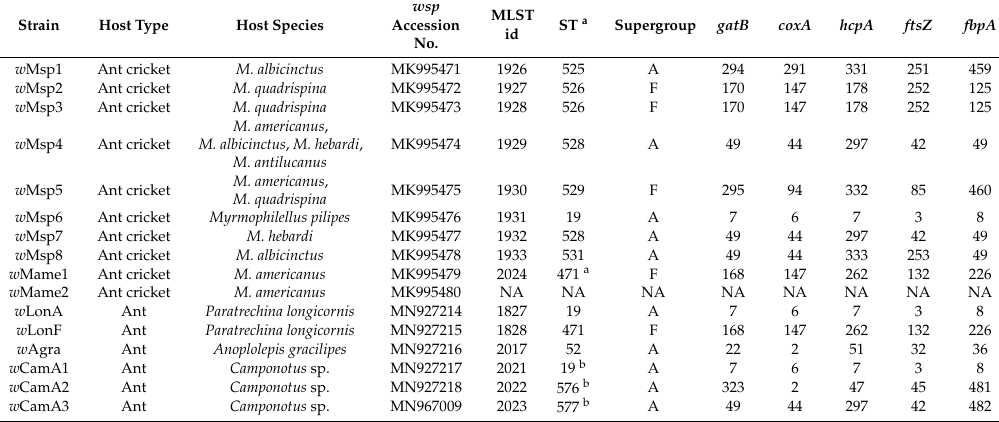
Table 1. wsp accession number and multi-locus sequence type (MLST) allelic profiles of the Wolbachia strains recovered from the tested ant crickets and ants in this